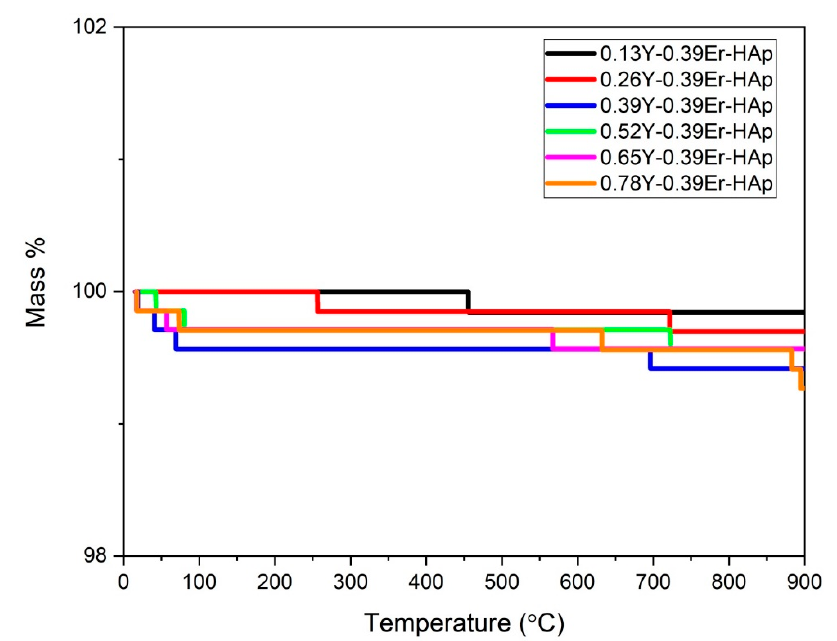
Figure 7. TGA thermograms.